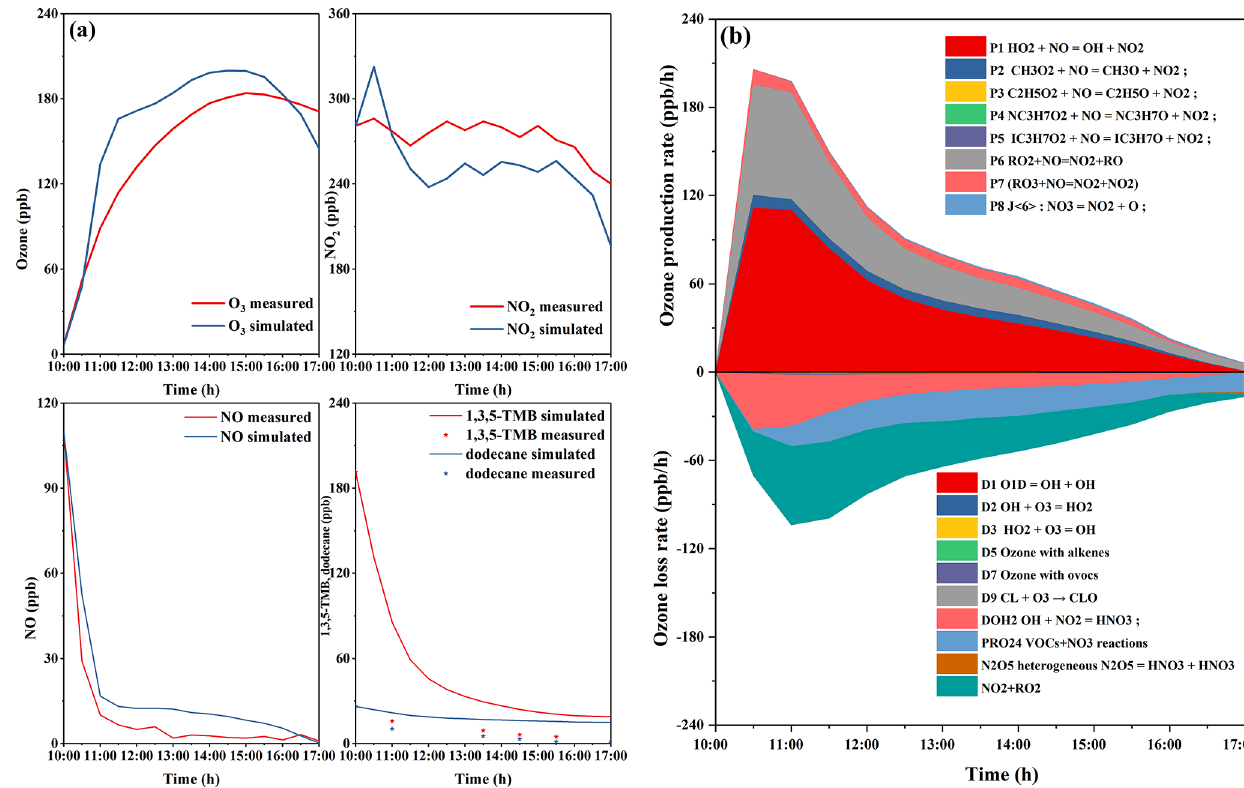
Figure 3. Concentration–time profiles of monitored and simulated (a) ozone, NO, NO 2 , and 1,3,5-TMB and dodecane and (b) ozone formation and loss rates in the H-HONO-Mix-4